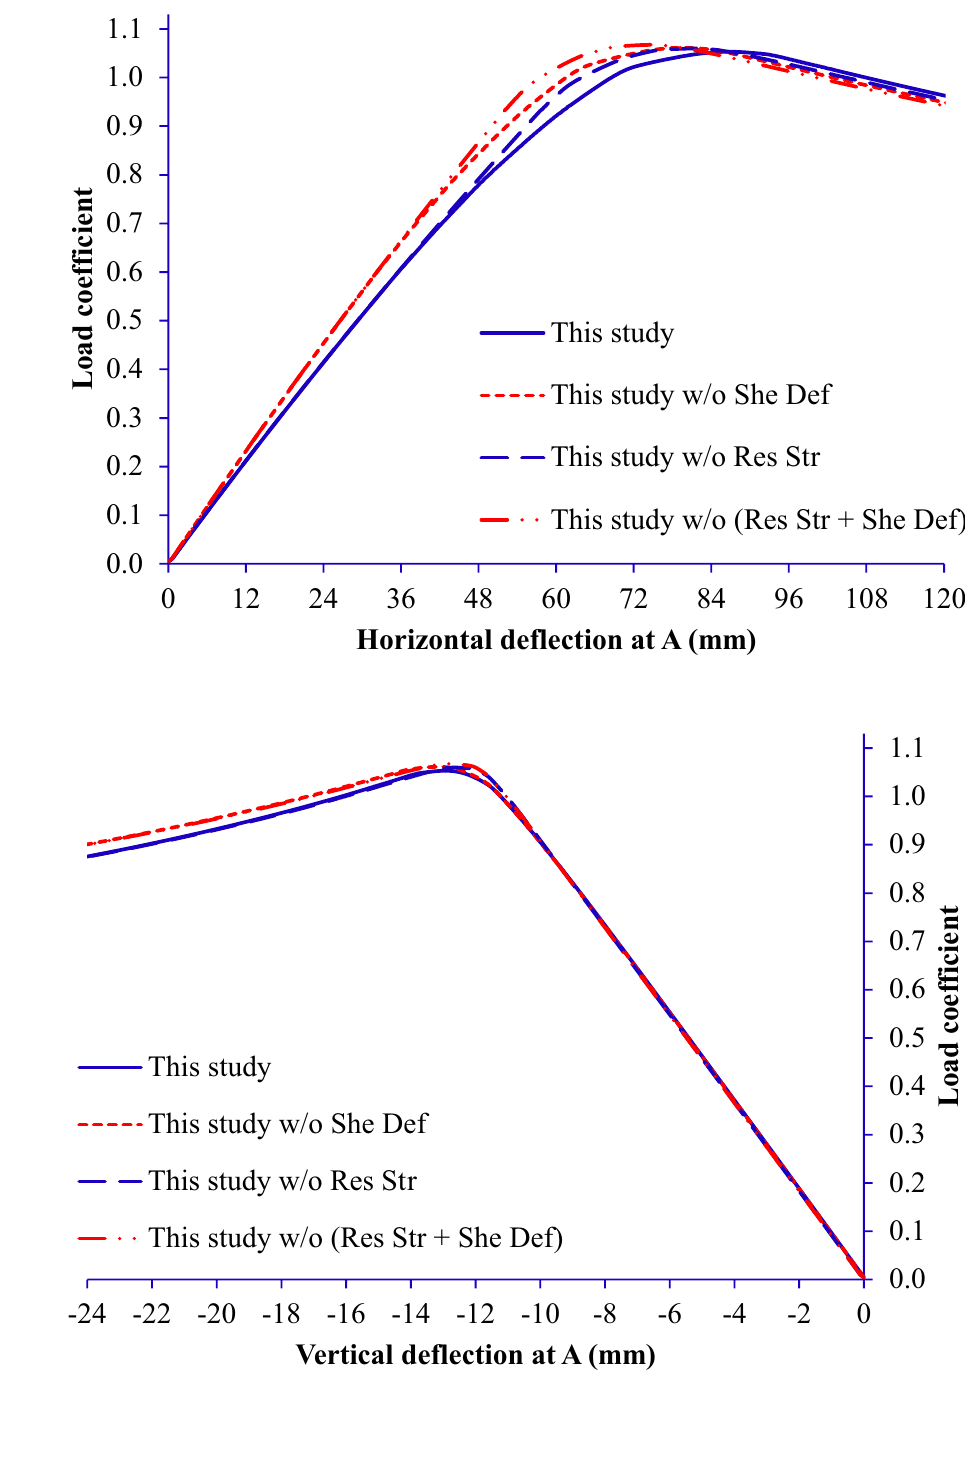
Fig. 27 Load-vertical deflec- tion relationship at A of nine- story